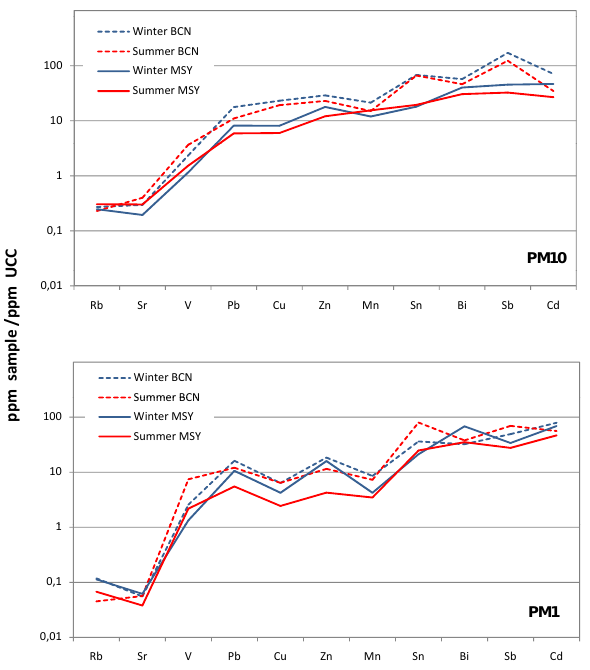
Fig. 3. Average metal values of BCN and MSY atmospheric PM 10 and PM 1 samples normalised to the average concentrations in the upper continental crust (UCC) (Wedepohl, 1995). Only the nine most technogenic metals (ratio > 1) are shown, plus for comparison Rb and Sr which represent more “crustal” PM